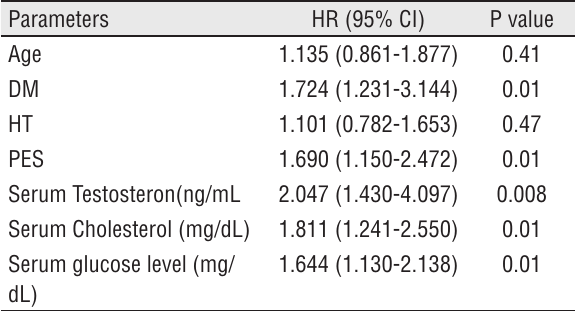
Table 3 - Results of mutivariate